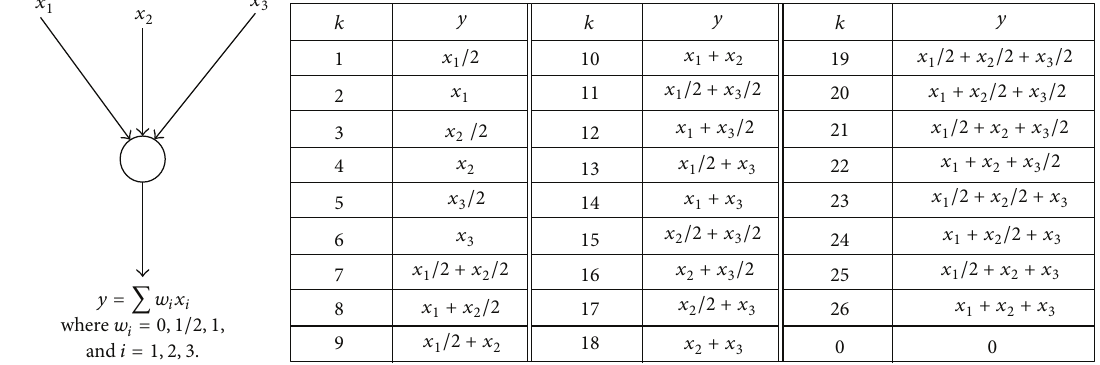
Figure 10: An illustration of definition of signal